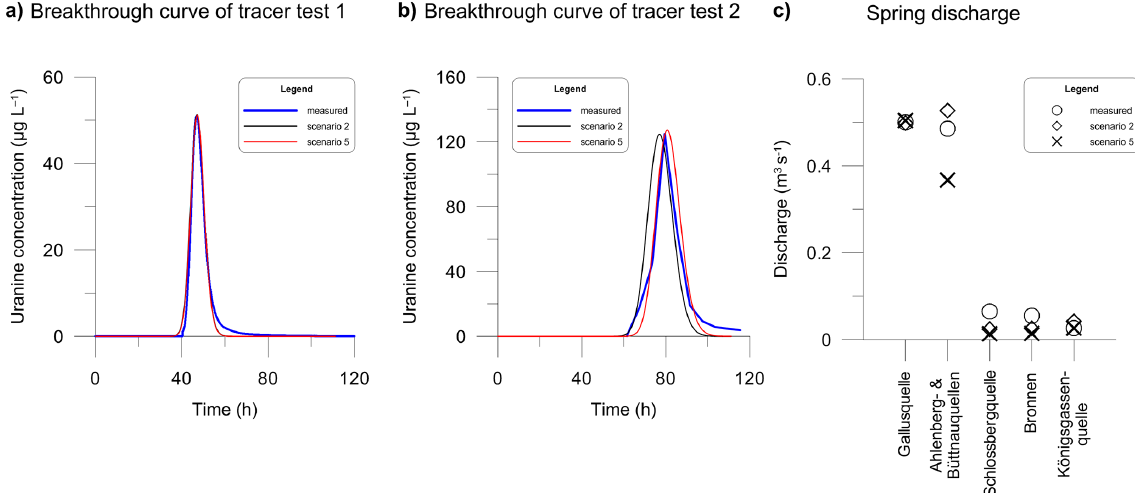
Figure 10. Comparison of the best-fit simulations with field data for scenarios 2 and 5. (a) Breakthrough curve of tracer test 1, (b) break- through curve of tracer test 2 and (c) spring